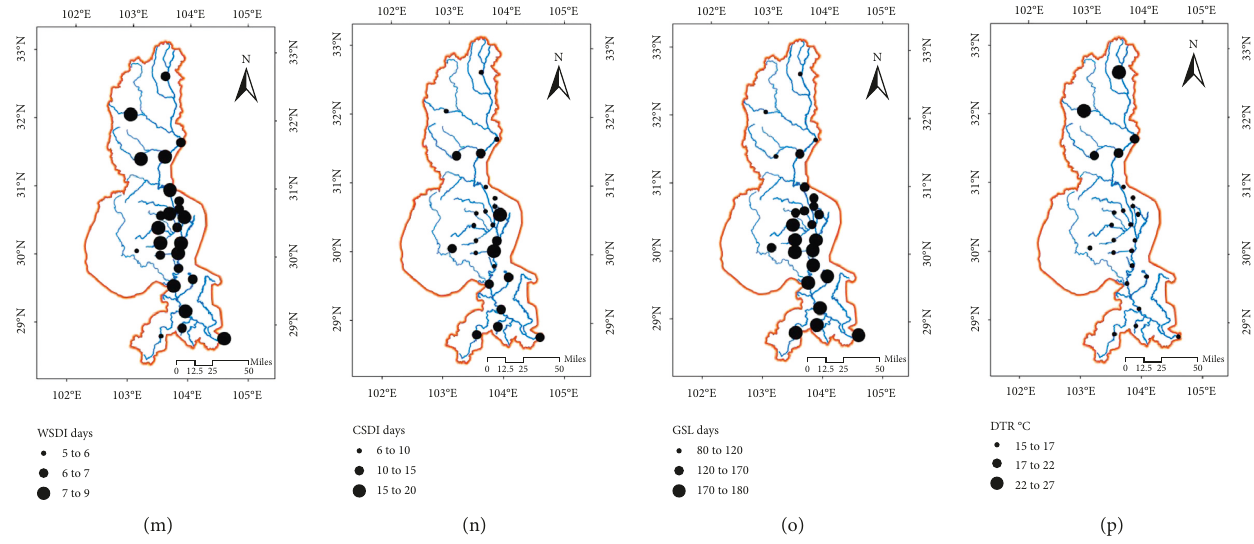
Figure 2: Spatial distribution of extreme temperature index in the Minjiang River Basin from 1961 to